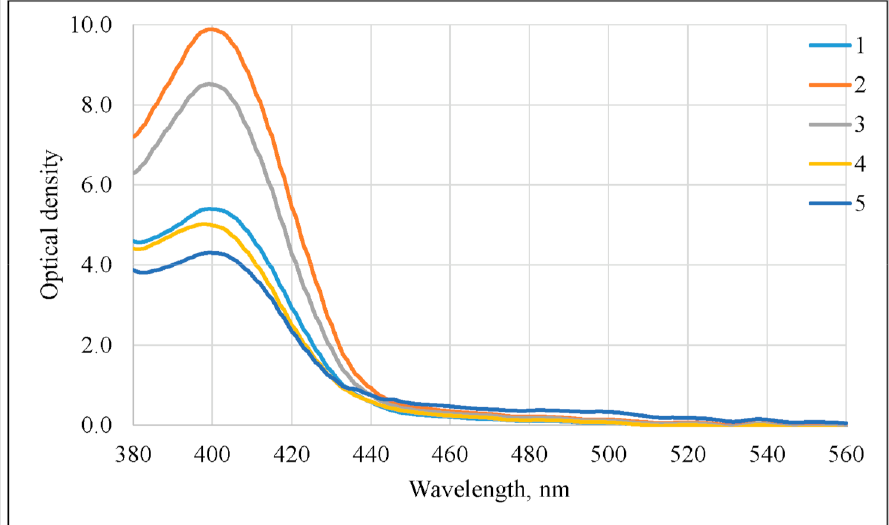
Figure 2. The absorption spectrum of samples obtained from the supernatant. The supernatants were obtained from samples of yeast S. cerevisiae 71B and cultured in 20% glucose solution with the addition of: (1) sterile dH 2 O, (2) 0.5 mM AgNO 3 , (3) 1.0 mM AgNO 3 , (4) 1.5 mM AgNO 3 and (5) 2.0 mM AgNO